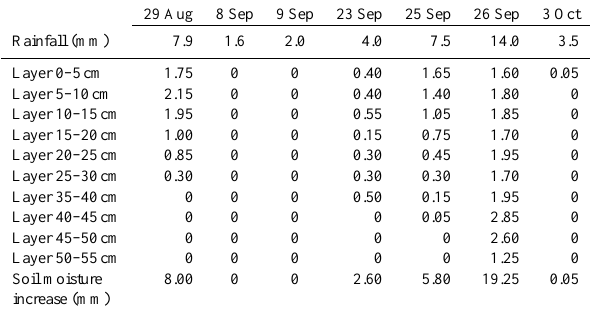
Table 2. Changes in cumulative infiltration (mm) at different soil